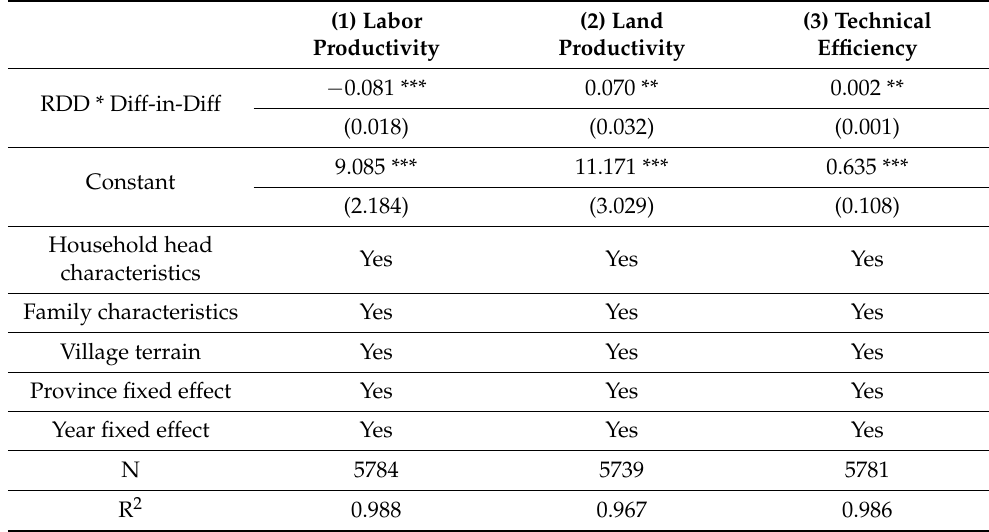
Table 7. The regression results for NRPS pensions affecting agricultural